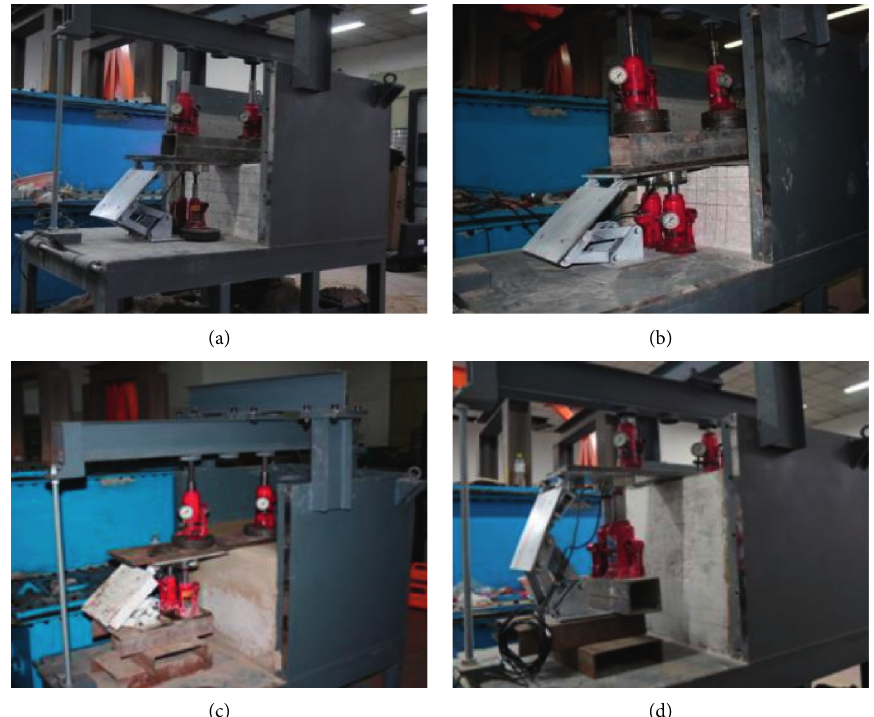
Figure 5: The model used for the physical simulations of a coal wall of different heights under load. (a) Mining height 3m. (b) Mining height 5m. (c) Mining height 7 m. (d) Mining height 9m.